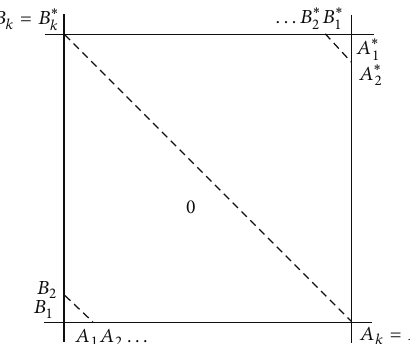
Figure 1: Separation line optimizing the cost of each algorithm.